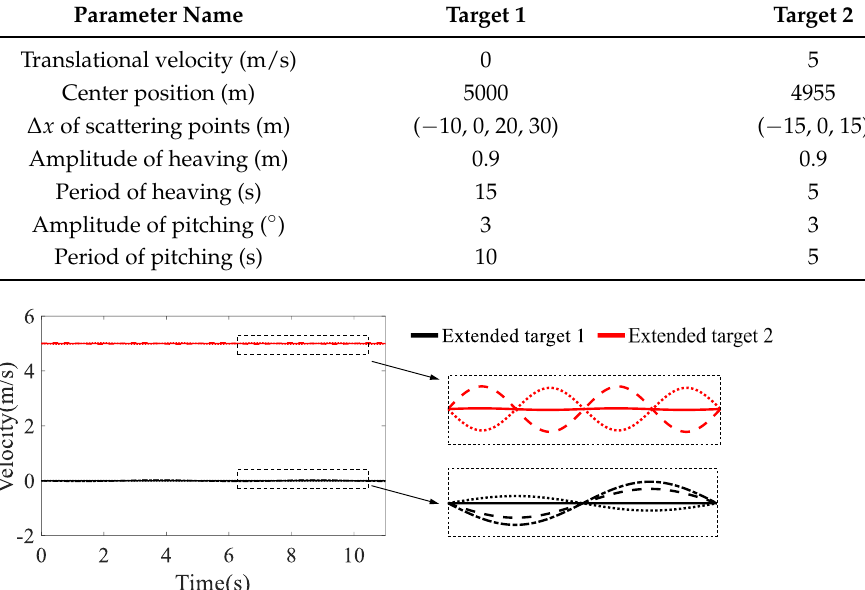
Figure 6. The theoretical velocities of the